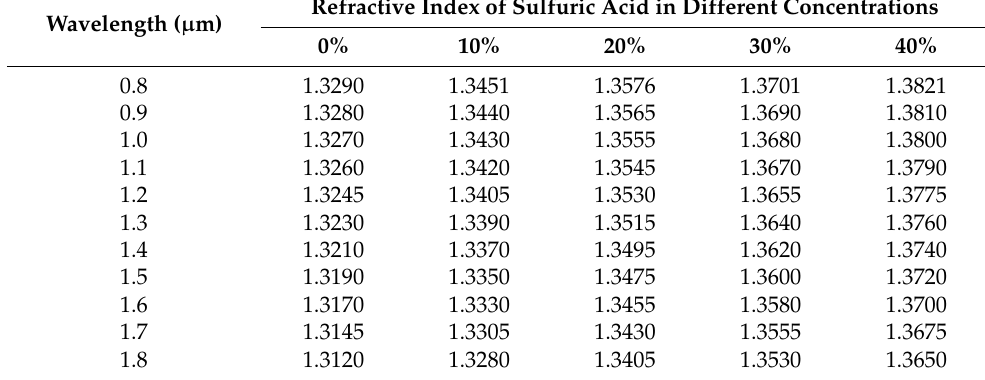
Table 1. Refractive index of sulfuric acid of different concentrations with respect to wavelength [16,23,24]. Refractive Index of Sulfuric Acid in Different Wavelength ( µ m)